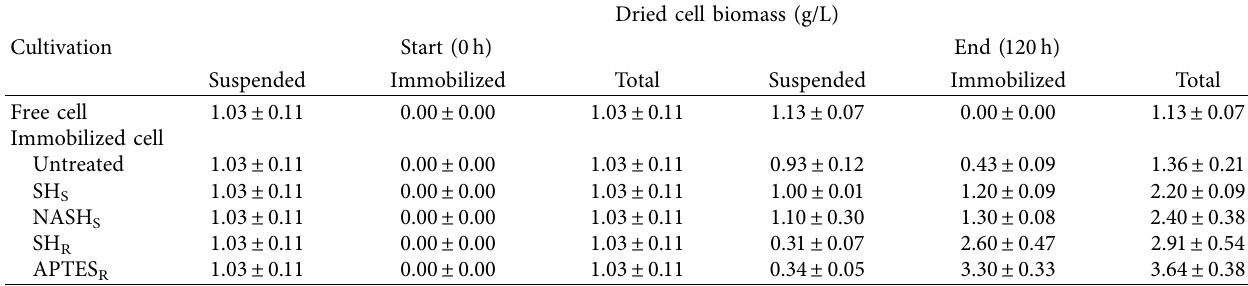
Table 3: Dried cell biomass of C. beijerinckii TISTR1461 in ABE fermentation when cultivated as free cells and immobilized cell cultures on the untreated and treated AC